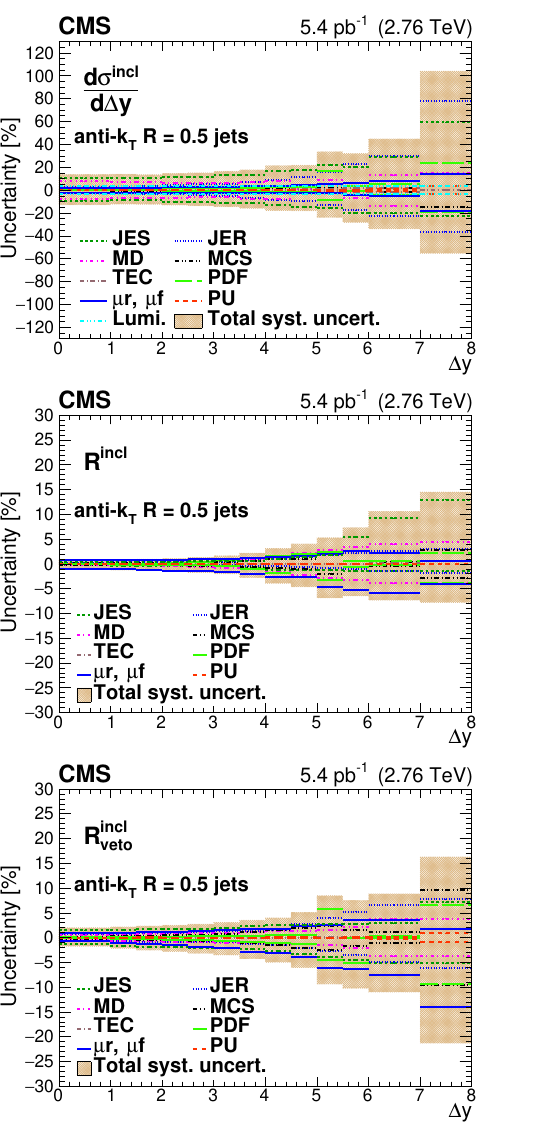
Figure 1 . Summary of the systematic uncertainties on the cross sections d σ incl / d∆ y (upper left) and d σ MN / d∆ y (upper right), as well as the ratios R incl (middle left), R MN (middle right), R incl (lower left), and R MN (lower right). The various contributions are indicated by the lines and the veto total uncertainty is shown with a